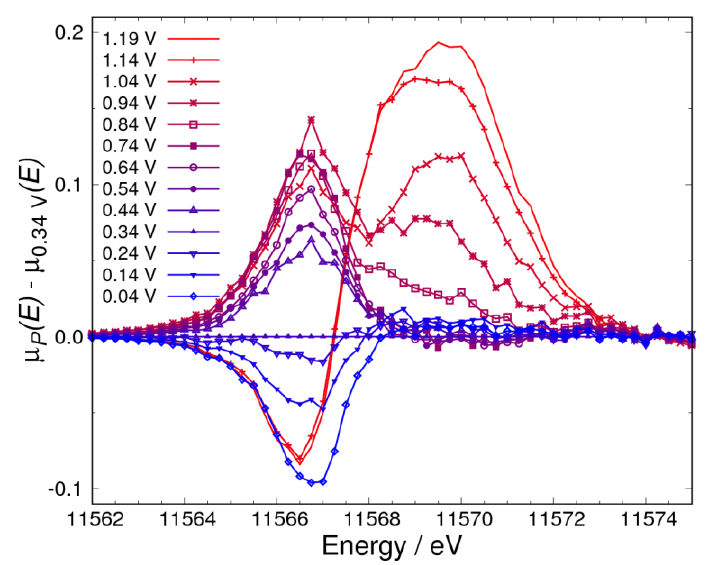
Figure 4. Δ μ XANES spectra for the catalyst calculated by 𝜇 𝑝 (E) − 𝜇 0.34V (E) under potential control in 1 M of KOH saturated with O 2 .